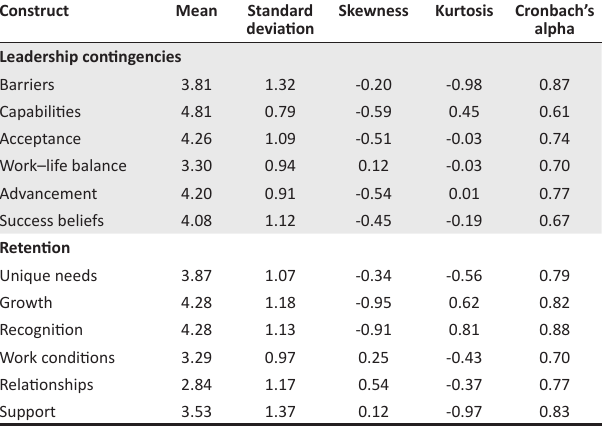
TABLE 1: Leadership and retention factors: Descriptives and Cronbach’s alpha.